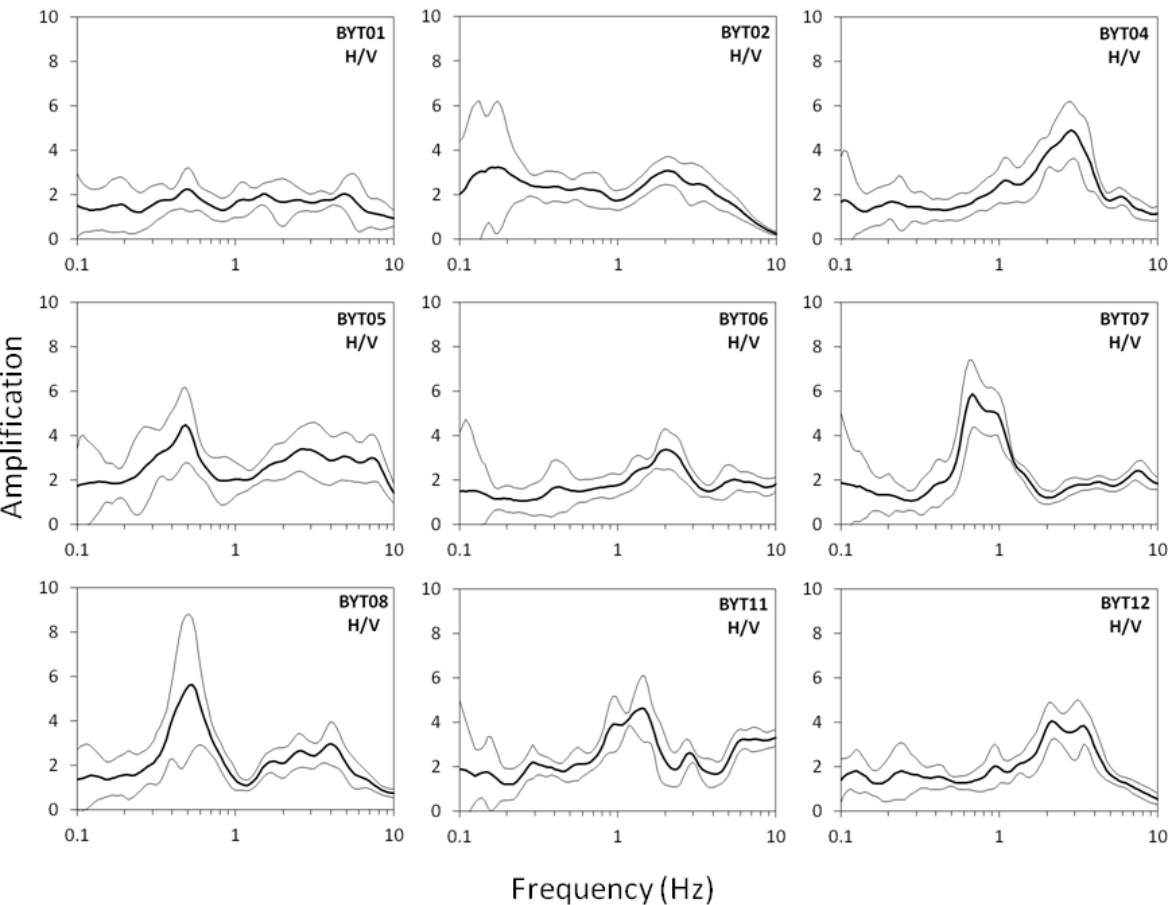
Figure 8. Horizontal-to-vertical spectral ratios (H/V) are computed using S waves of the earthquakes recorded at each station. Thick and thin lines represent the average and ±1 standard deviation curves,